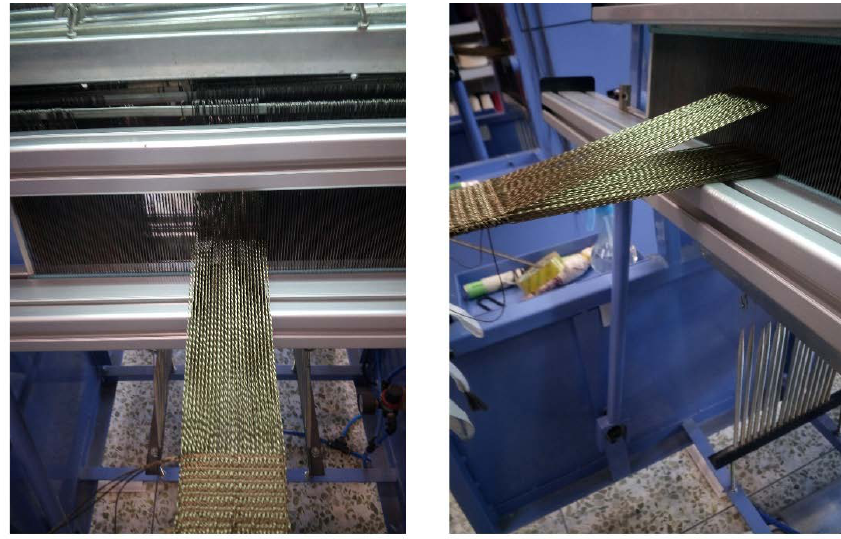
Figure 2. Weaving image of the 3D woven preform on the loom.